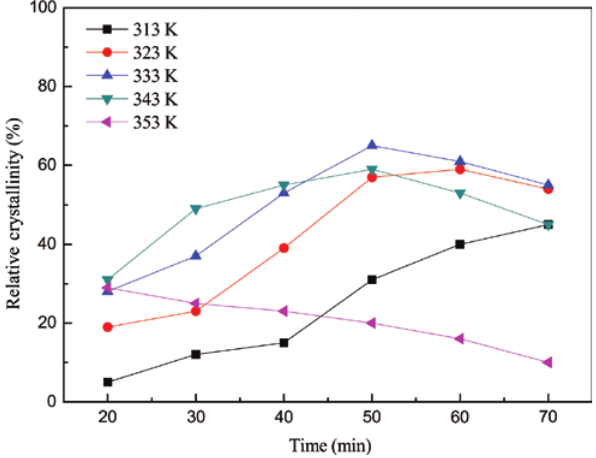
Figure 2: The relative crystallinities of zeolite NaY at different aging conditions of structure-directing